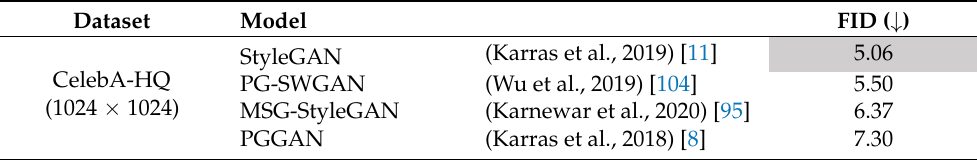
Table 14. The FID of different models trained on CelebA-HQ higher resolution image dataset. The lower the FID value, the better the